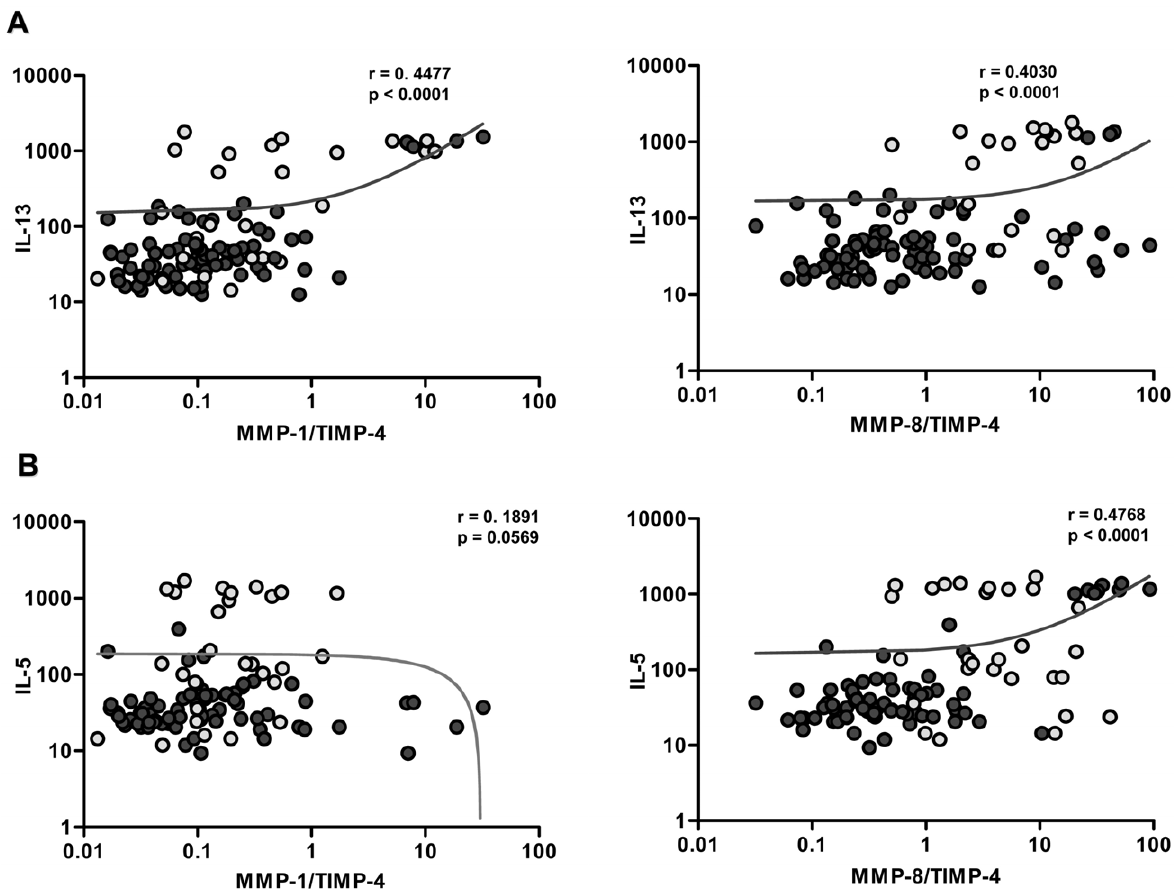
Figure 6. Correlation between MMP/TIMP ratios and Type 2 cytokines in filaria-infected individuals. (A) MMP/TIMP ratios were correlated with the levels of IL-13 from individuals with active infection [CP Ag + and INF ( n =102–114)]. (B) MMP/TIMP ratios were correlated with the levels of IL-5 from individuals with active infection [CP Ag + and INF ( n =102–114)]. CP Ag + individuals are shown in gray circles and INF in dark circles. P and r values were calculated using the Spearman rank correlation test.